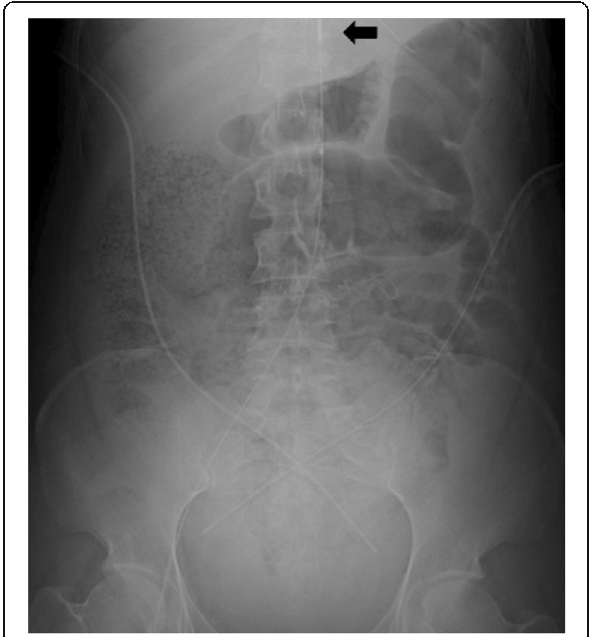
Fig. 1 Balloon position was confirmed by abdominal X-ray in the operating room after surgery. The black arrow indicates the tip of the catheter placed at zone II of the